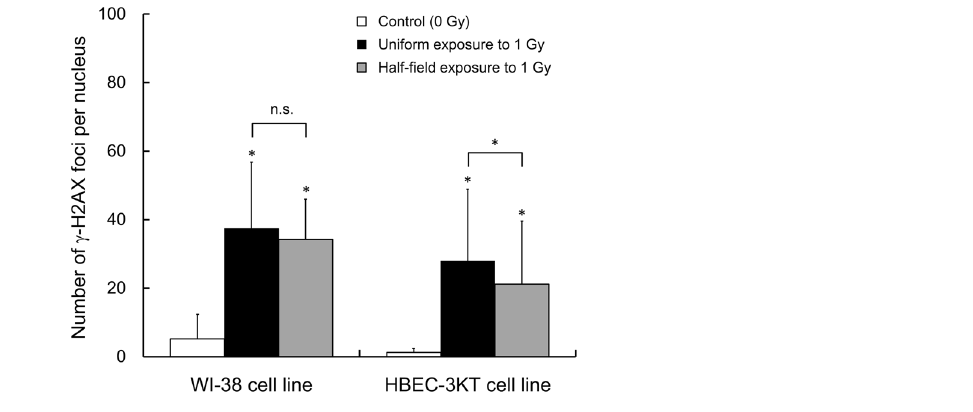
Figure 5. Reduced number of γ -H2AX foci under heterogeneous exposure. To demonstrate the non-uniform exposure, the half-field (with 50% in the culture dish exposed) experiment is conducted. The γ -H2AX foci were observed 30 min after irradiation with 6 MV-linac X-rays. The symbol of * and n.s. represents 5% significant difference and no significant difference,